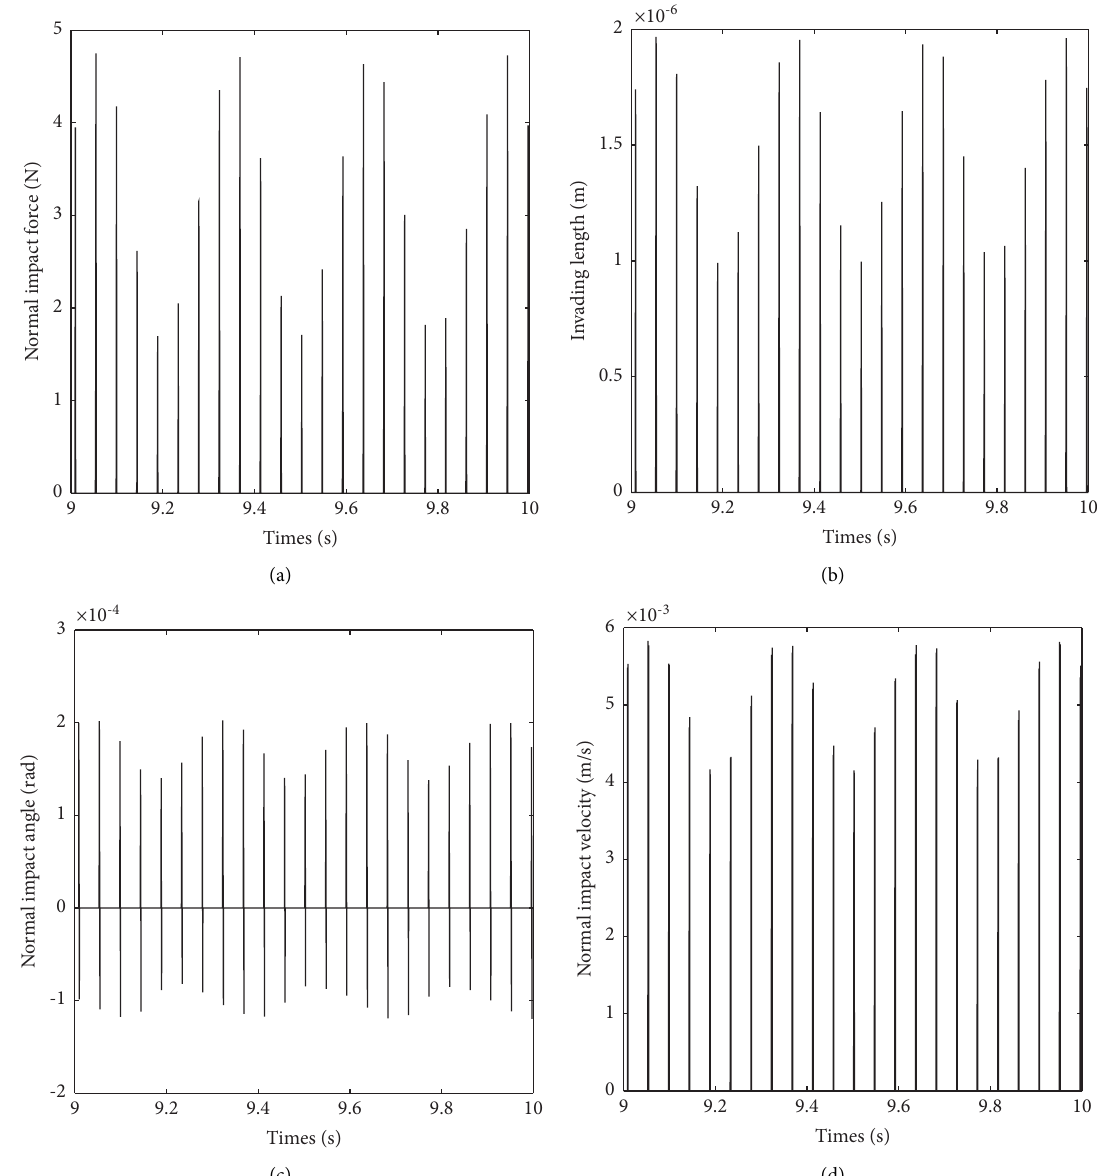
Figure 18: Rubbing process of the MSDS with K